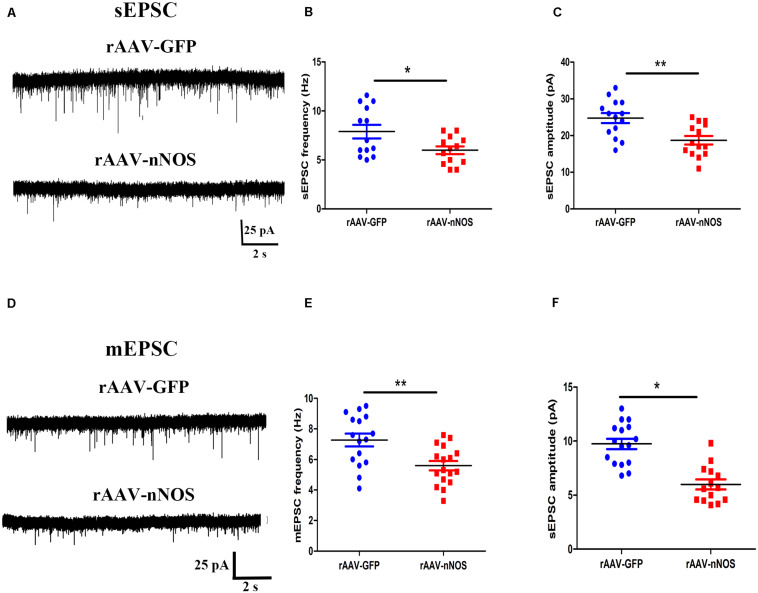
Effects of nNOS downregulation on excitatory synaptic transmission in slice from nNOS interneurons in mice. (A) Continuous recordings of spontaneous excitatory postsynaptic current (sEPSC) from typical cells in mice injected with rAAV-GFP (upper) and rAAV-nNOS (bottom). Summary graph of mEPSC frequency (B) and amplitude (C) for cells from control and rAAV-nNOS-injected mice. rAAV-GFP: n = 14 cells in 5 mice; rAAV-nNOS: n = 14 cells in five mice. (D) Representative recordings of miniature excitatory postsynaptic current (mEPSC) in control (upper) and rAAV-nNOS-treated mice (bottom). Summary graph of mEPSC frequency (E) and amplitude (F) in rAAV-GFP-treated and nNOS-deficient mice. n = 16 cells in 5 mice; rAAV-nNOS: n = 17 cells in 5 mice. *p < 0.05, **p < 0.01, compared with rAAV-GFP-injected animals, unpaired t-test. Data are presented as means ± SEM.